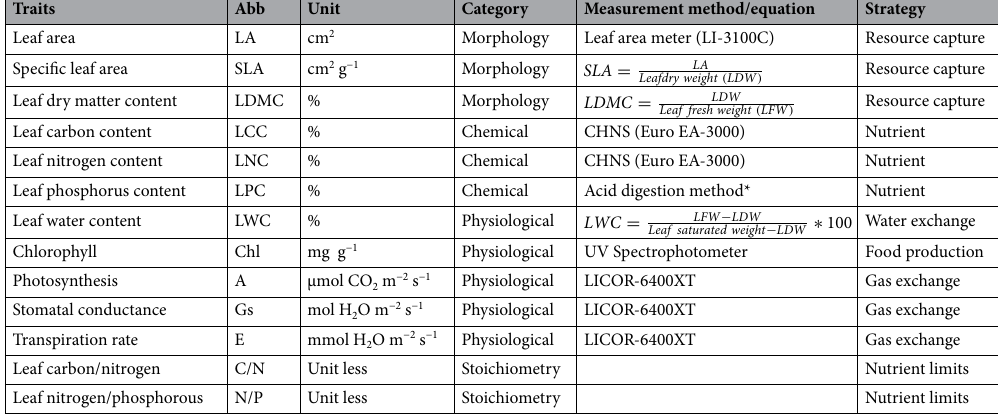
Table 2. Leaf traits, abbreviations (Abb), units, measurement method/equation, and strategy in a temperate forest in Mussoorie Forest Division, Uttarakhand, Indian Himalayas. *Species and their Voucher IDs used for